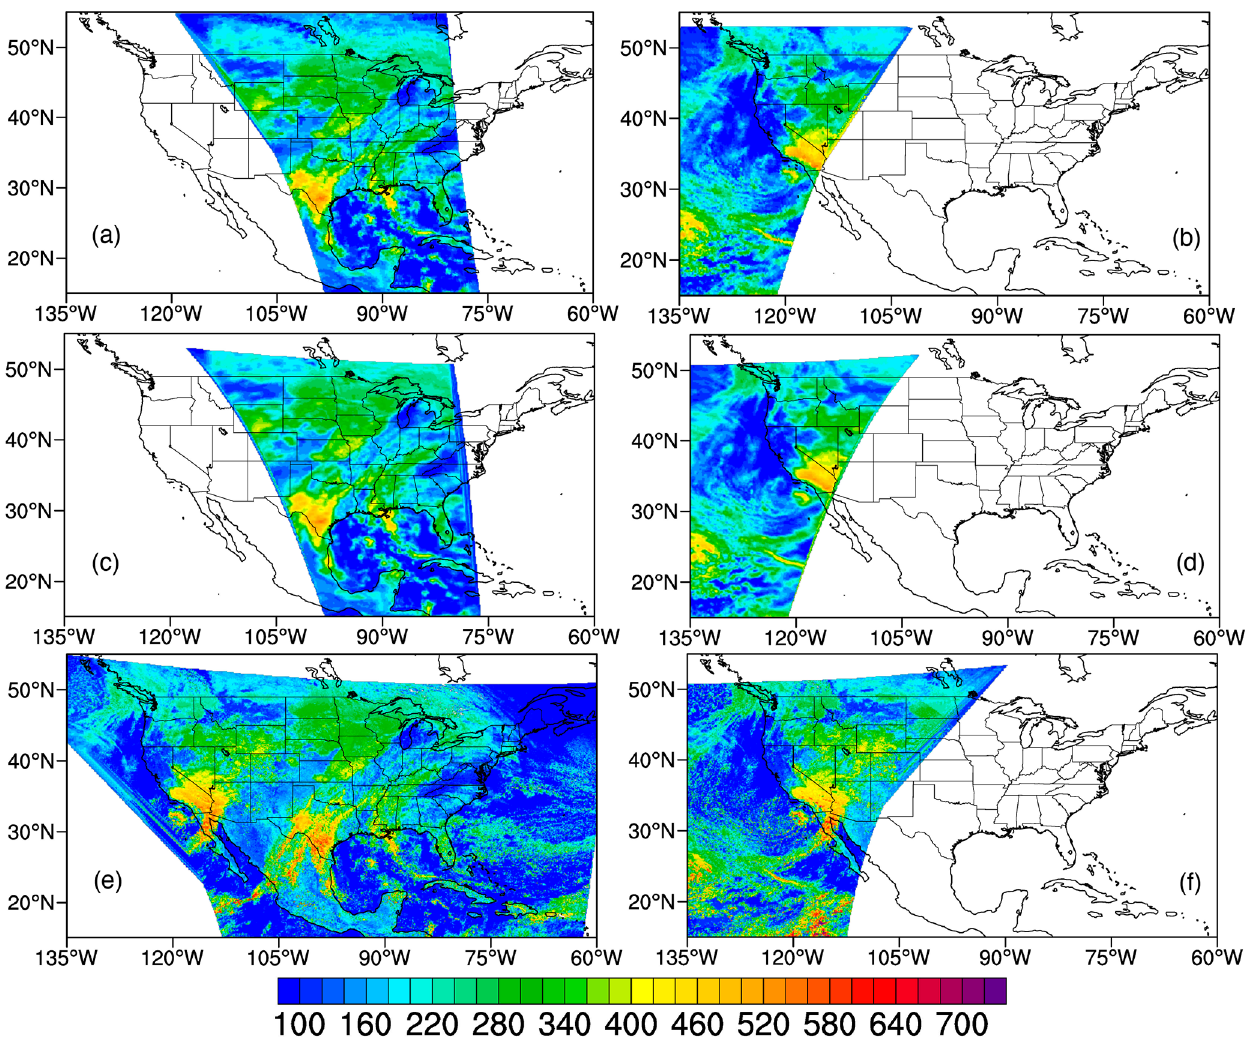
Figure 11. All-sky TOA SW from (a) CERES_SSF/Aqua, (b) CERES_SSF/Terra, (c) re-gridded CERES_SSF/Aqua, (d) re-gridded CERES_SSF/Terra, (e) GOES-16, and (f) GOES-17: all on 26 December 2019 at